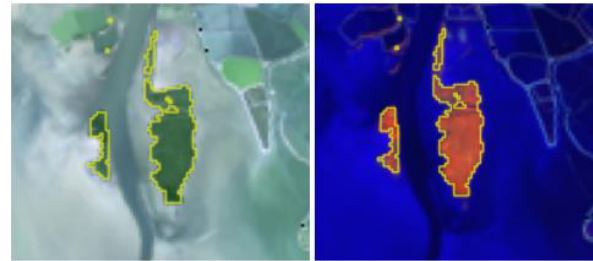
Figure 8. Detected Dense Mangrove Forest